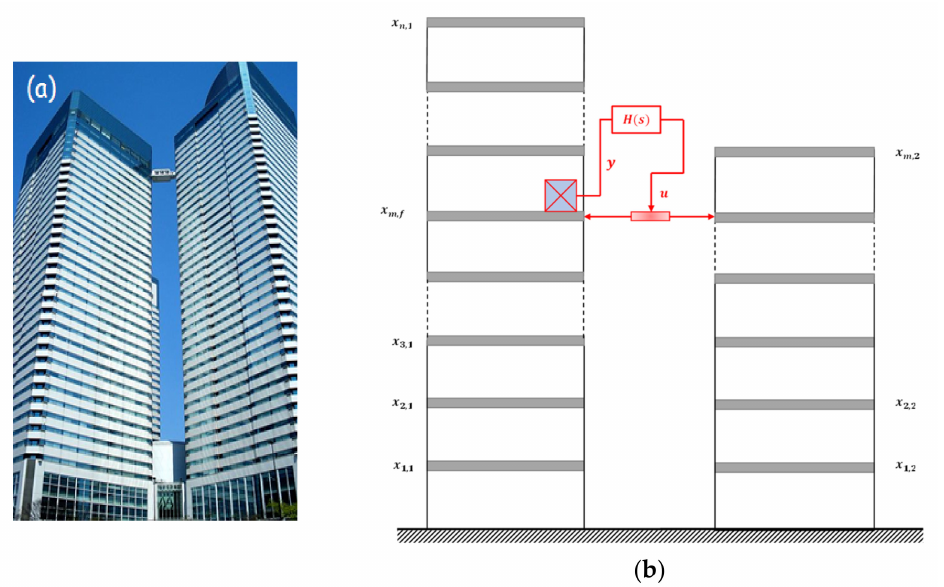
Figure 16. ( a ) Active CBC of Harumi Triton Square in Tokyo, Japan; ( b ) model of two adjacent buildings connected with an active strut.